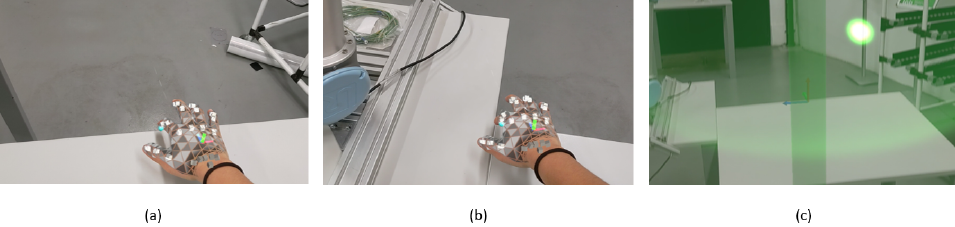
Figure 2. Coordinate system definition: ( a ) finger marking the origin’s place. ( b ) Finger marking the point that would define the referential frame orientation. ( c ) Setup